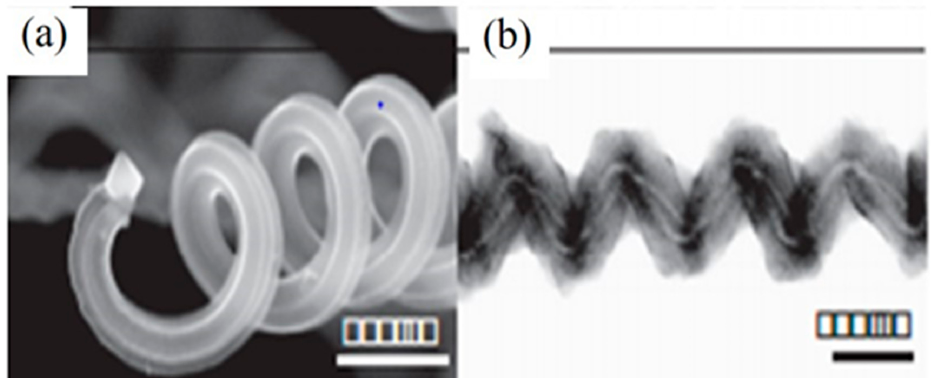
Figure 9. SEM image of helically coiled CNTs ( a ) Tip of a coil. The scale bar is 600 nm; ( b ) TEM image of two tubules, forming a coil with different diameters, but the similar pitch, and a small alteration in phase. The scale bar is 100 nm. Reproduced with permission from [84]. Copyright Elsevier, 2009. CNTs are also found in branched structures resembling letters L, Y, T, and more complex connections which were firstly detected in nanotubes synthesized by arc ‐ discharge [95]. The CNT Y ‐ connections are made by the decoration of hexagonal network with non ‐ hexagonal rings, where the three outlets of the Y are joined [96,97]. The initial synthesis was figured out in Y ‐ shaped templates by acetylene pyrolysis in the year [98]. Branched SWCNTs are understood to have an extreme control on electronic devices, as they can be used as nano ‐ transistor, nano ‐ diode, and nano ‐ interconnect in nano ‐ electron devices [84]. CNTs with beads have been obtained in different processes [15,99–104]. Beads appear in different forms, and they may have either polycrystalline or amorphous graphite. Their formation is due to the increase in the viscosity of viscous carbon on the nanotube surface, and deterioration of beading process upon the cooling process. As shown in Figure 10, the nanotube can be clearly seen inside the bead. Such CNTs are likely to be used in composites as fillers to improve matrix material electrical conductivity, and mechanical strength, due to the reason that the beads prevent the nanotubes from slipping in the composite materials [84].